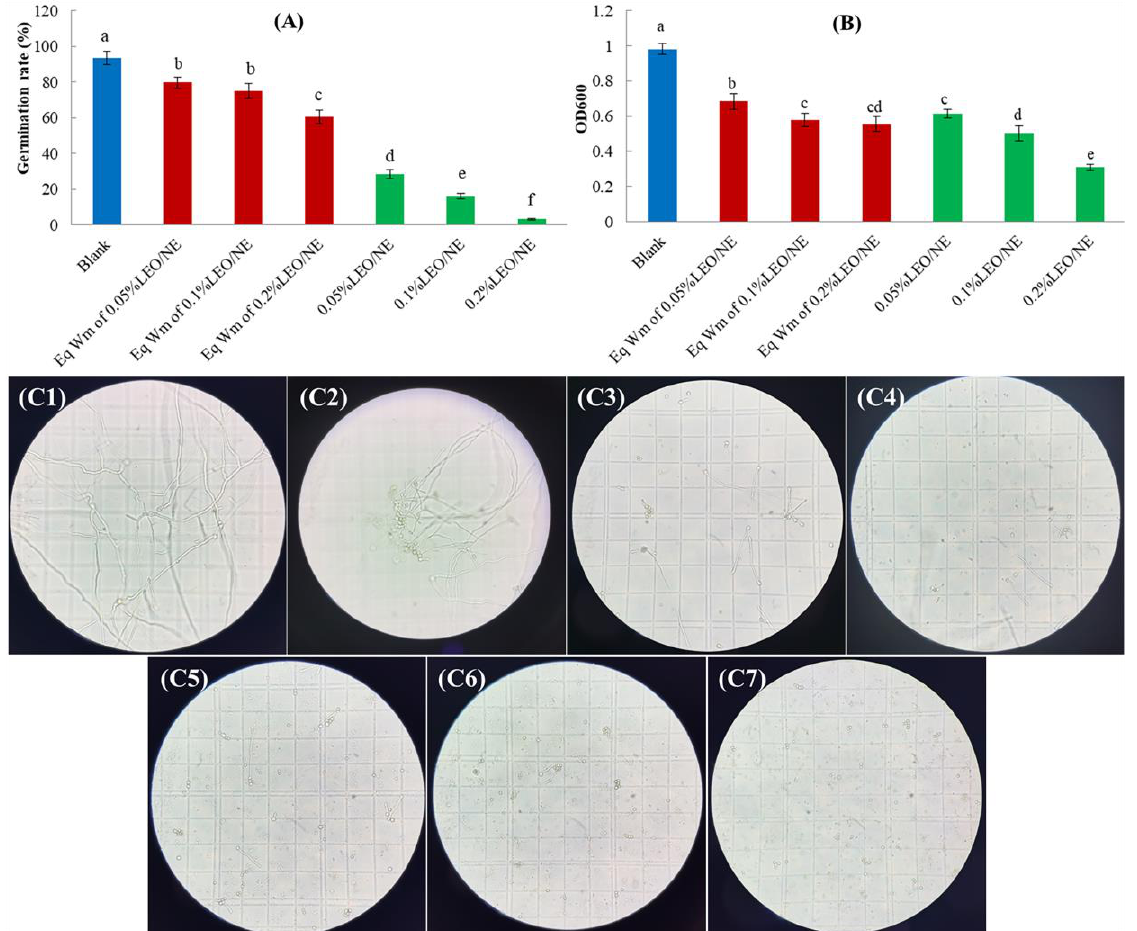
Figure 2. Spore germination of Phomopsis sp. under the treatment of lemon essential oil nanoemulsion (LEO/NE) and equivalent wall material (Eq Wm). ( A ) spore germination rate; ( B ) optical density at 600 nm (OD600); ( C1 ), ( C2 ), ( C3 ), ( C4 ), ( C5 ), ( C6 ) and ( C7 ) was microscopic observation of the spore germination at treatment of Blank, Eq Wm of 0.05%LEO/NE, Eq Wm of 0.1%LEO/NE, Eq Wm of 0.2%LEO/NE, 0.05%LEO/NE, 0.1%LEO/NE and 0.2%LEO/NE, respectively. Different letters above each column of (A) and (B) indicate significant differences.